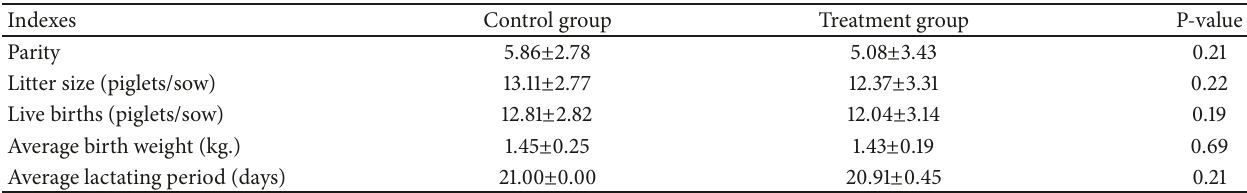
Table 1: Comparison of fundamental production indexes between control group (no suckling sound; n=15) and treatment group (suckling sound; n=15) (mean ± SD).